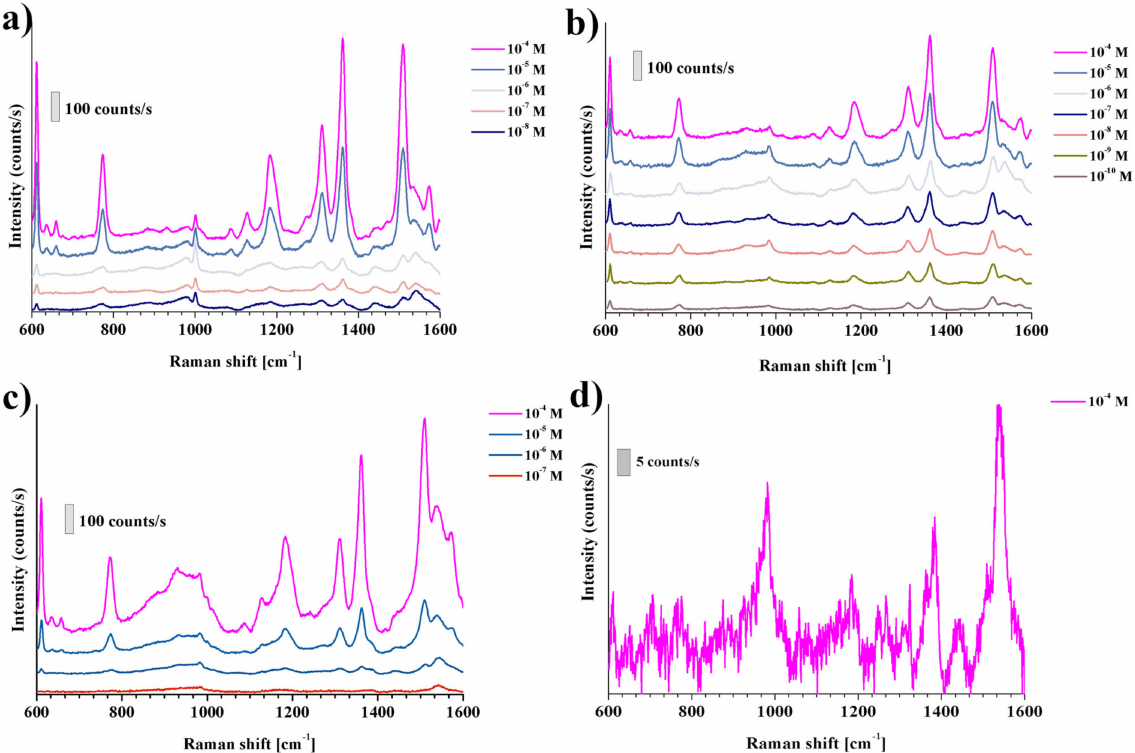
Figure 11. SERS spectra of R6G deposited on WO 3 nanopores surfaces coated with Au trisoctahedral nanoparticles: ( a ) 71 nm; ( b ) 94 nm; and ( c ) 115 nm; ( d ) SERS spectrum of R6G deposited on flat WO 3 coated with Au trisoctahedral nanoparticles (94